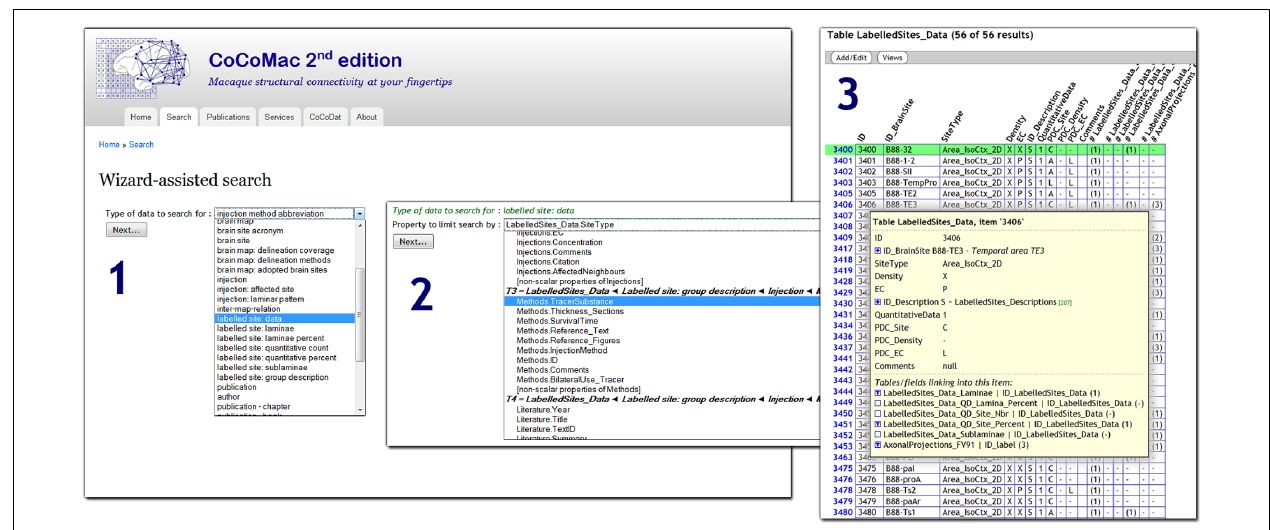
FIGURE 1 | Screenshot of the CoCoMac 2.0 search wizard (http://cocomac.g-node.org/search_wizard), with three steps highlighted: (1) selection of the data type (any database table); (2) selection of search criterion (field from table that is recursively related to data type); (3) interactive result table, expanding the tree shows all related